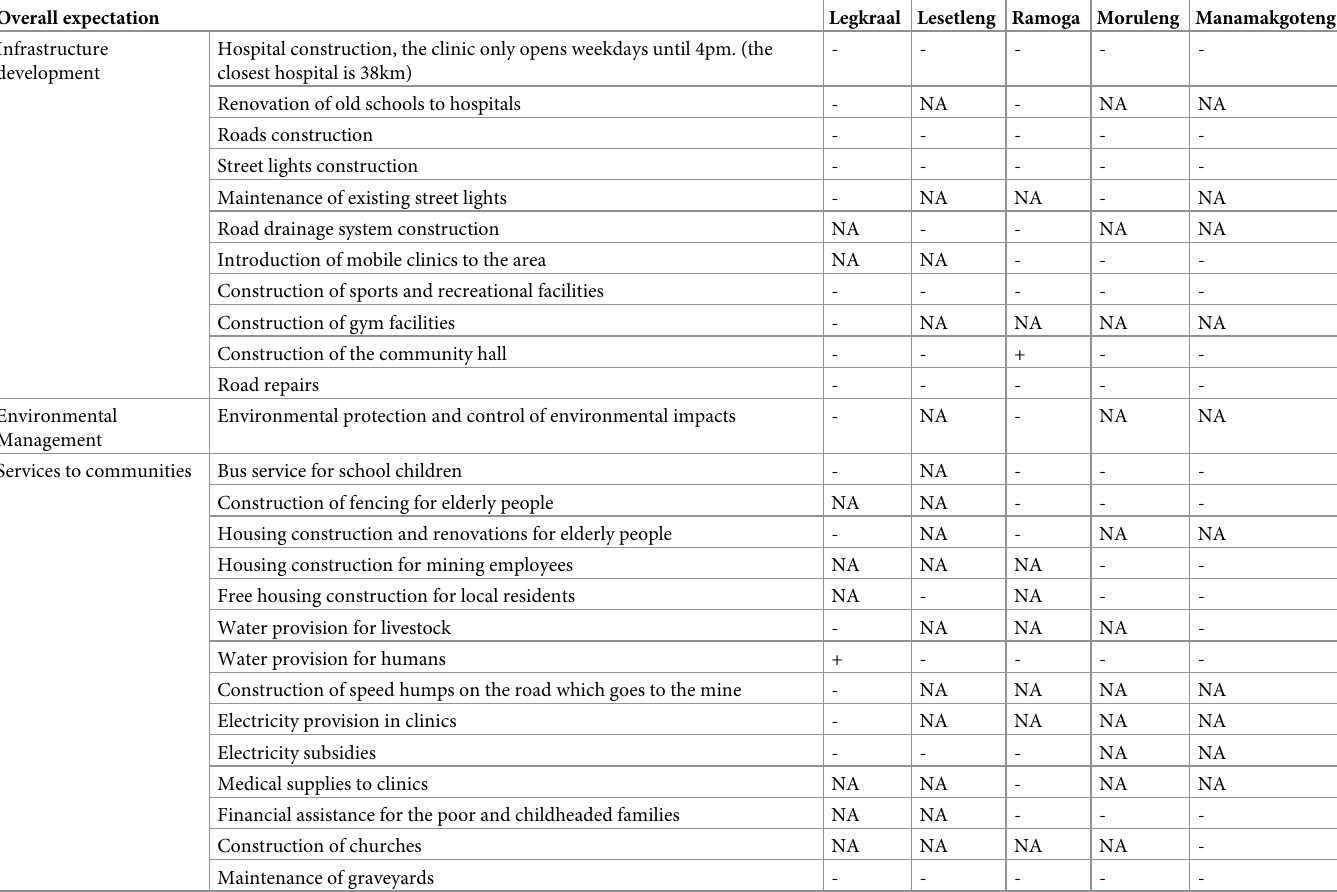
Table 1. Expected and delivered services to local communities by the local mining industry. (-) = expected but not delivered services; (+) = exepected and actually delivered services; NA = services not reported as expected from the local mining industry in a given community. Overall expectation Infrastructure